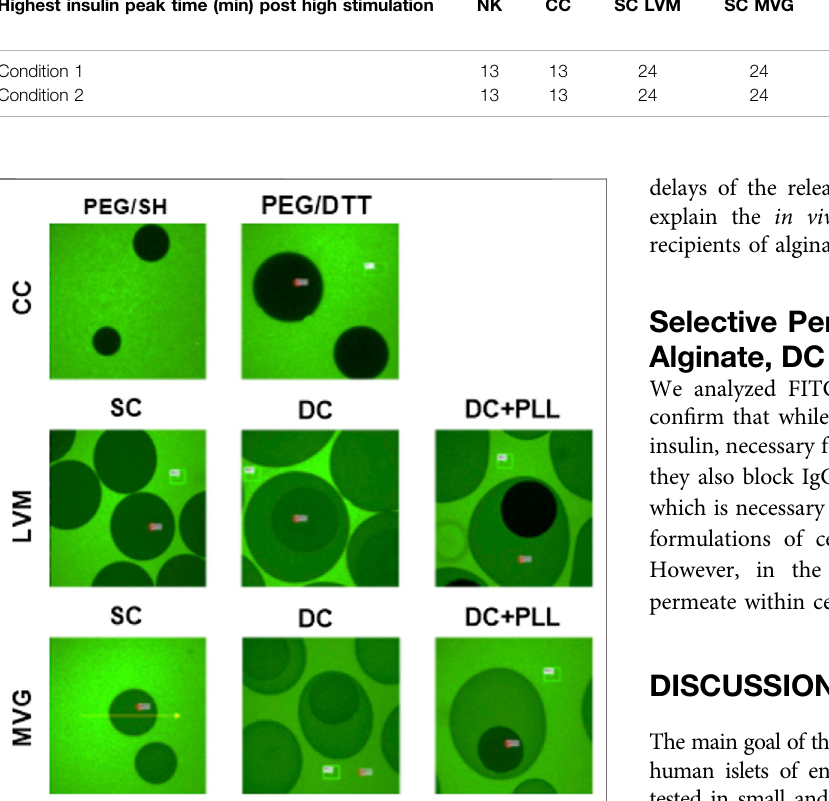
TABLE 5 | Model calculated time delays in fi rst phase insulin response after L1 → H glucose switch for 150 µm standard islet size (condition 1) and for the experimentally measured average HI diameters (condition 2). Highest insulin peak time (min) post high stimulation